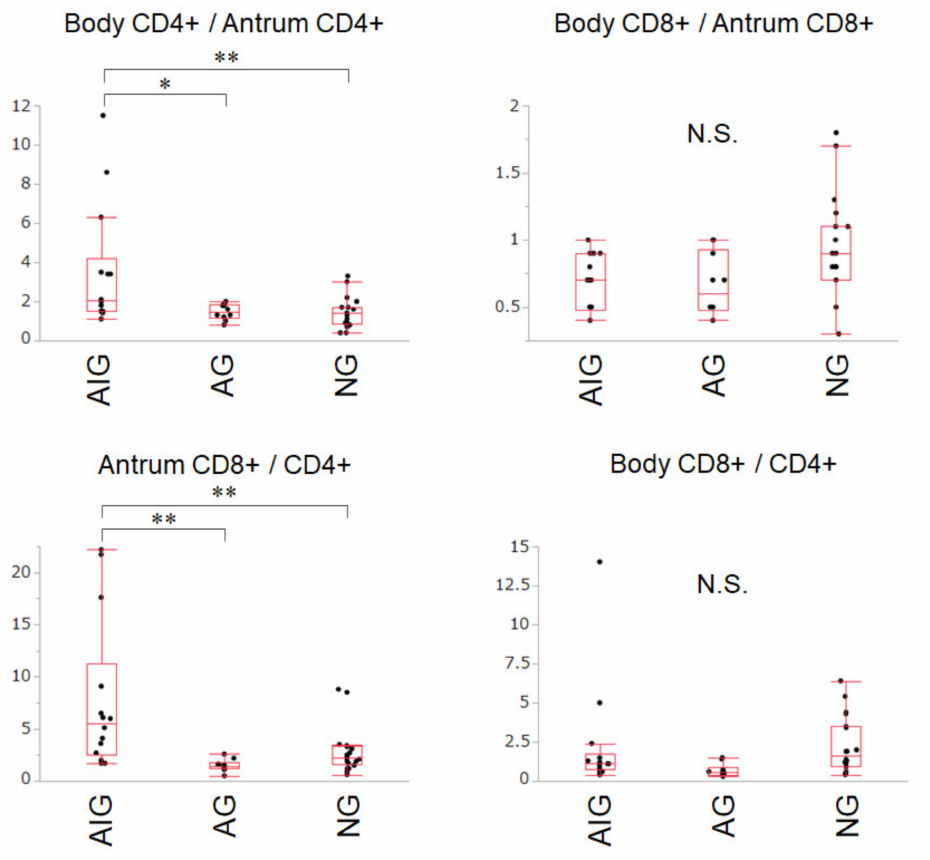
Figure 2. Box plots of the four potential markers combining CD4 + /CD3 + and CD8 + /CD3 + ratios in the greater curvature of the antrum and those of the lesser curvature of the body. * p < 0.05; ** p < 0.01; AIG: autoimmune gastritis ( n = 14); AG: active gastritis ( n = 10); NG: inactive gastritis ( n = 20); N.S.: no significant differences.